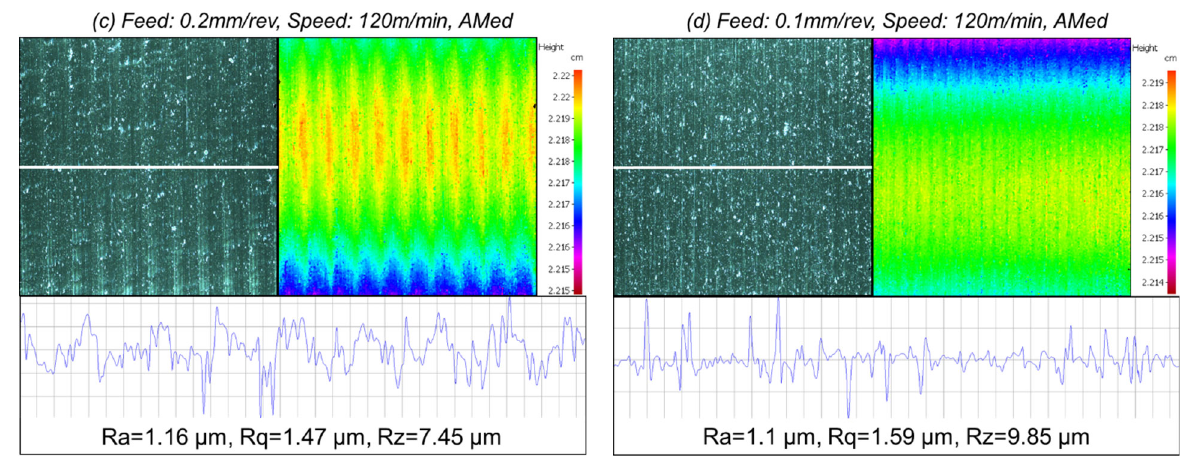
Figure 12. Profile of the machined surface of SLMed Ti6Al4V at the cutting depth of 0.25 mm, ( a ) feed rate: 0.1 mm/rev, speed: 80 m/min; ( b ) feed rate: 0.2 mm/rev, speed: 80 m/min; ( c ) feed rate: 0.2 mm/rev, speed: 120 m/min; ( d ) feed rate: 0.1 mm/rev, speed: 120 m/min.